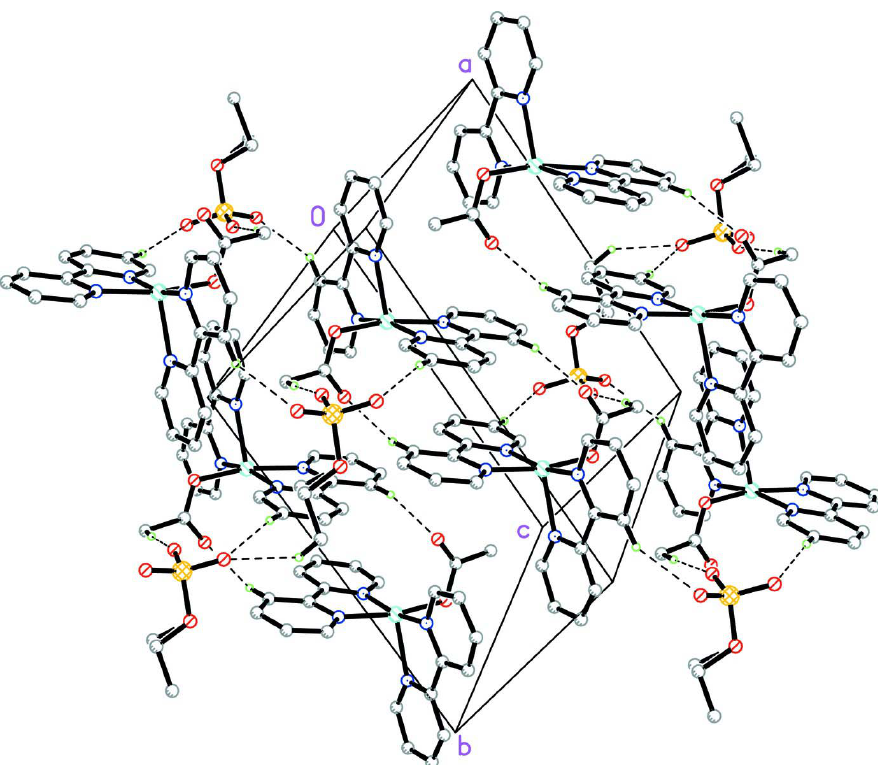
Figure 2 Part of the crystal structure showing hydrogen bonds as dashed lines. H atoms, except for those involved in hydrogen bonds, are not